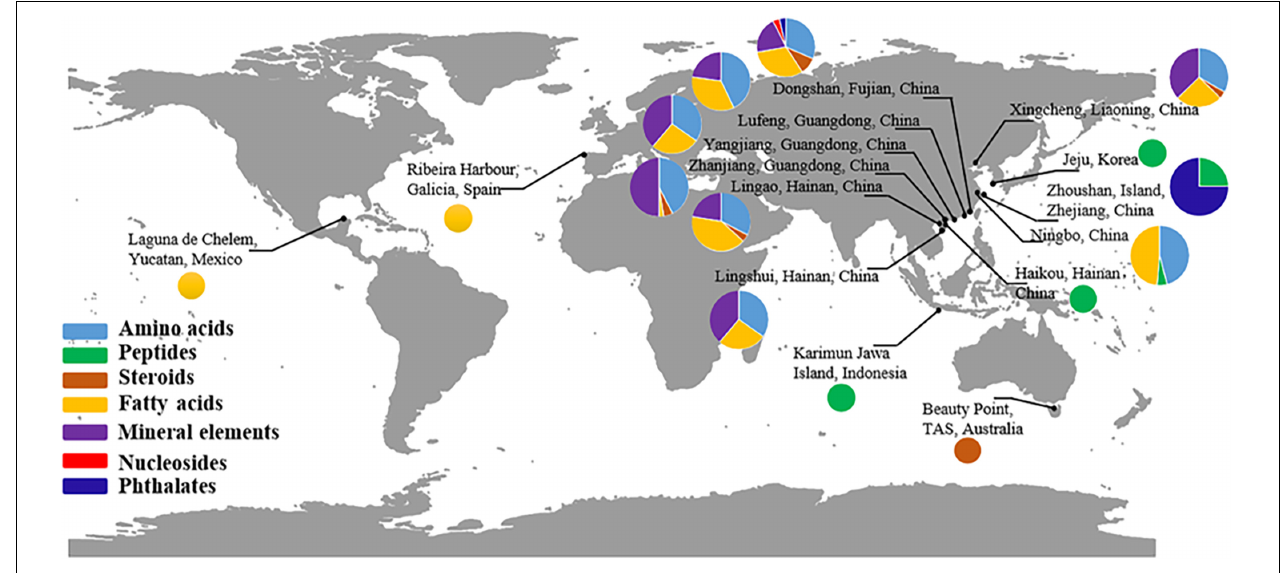
FIGURE 5 | Global distribution of main chemical ingredients in